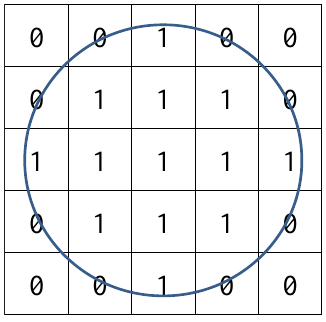
Figure 4: Circular CA Filter of 5 x 5 neighbourhoods